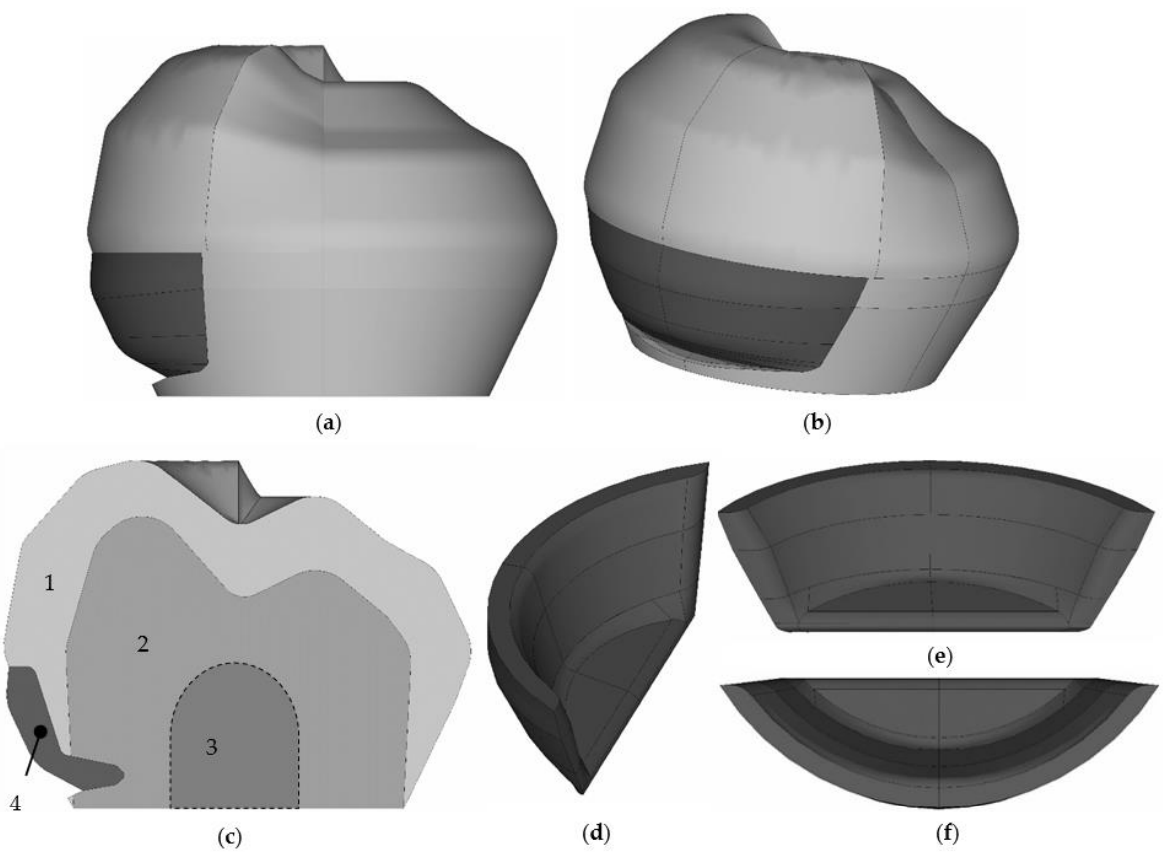
Figure 3. Tooth with a prosthetic inlay: ( a , b ) are isometry; ( c ) is the central section; ( d ) is inlay isometry; ( e ) is inside view inlay; ( f ) is top view inlay; 1 is enamel; 2 is dentine; 3 is pulp; 4 is inlay.